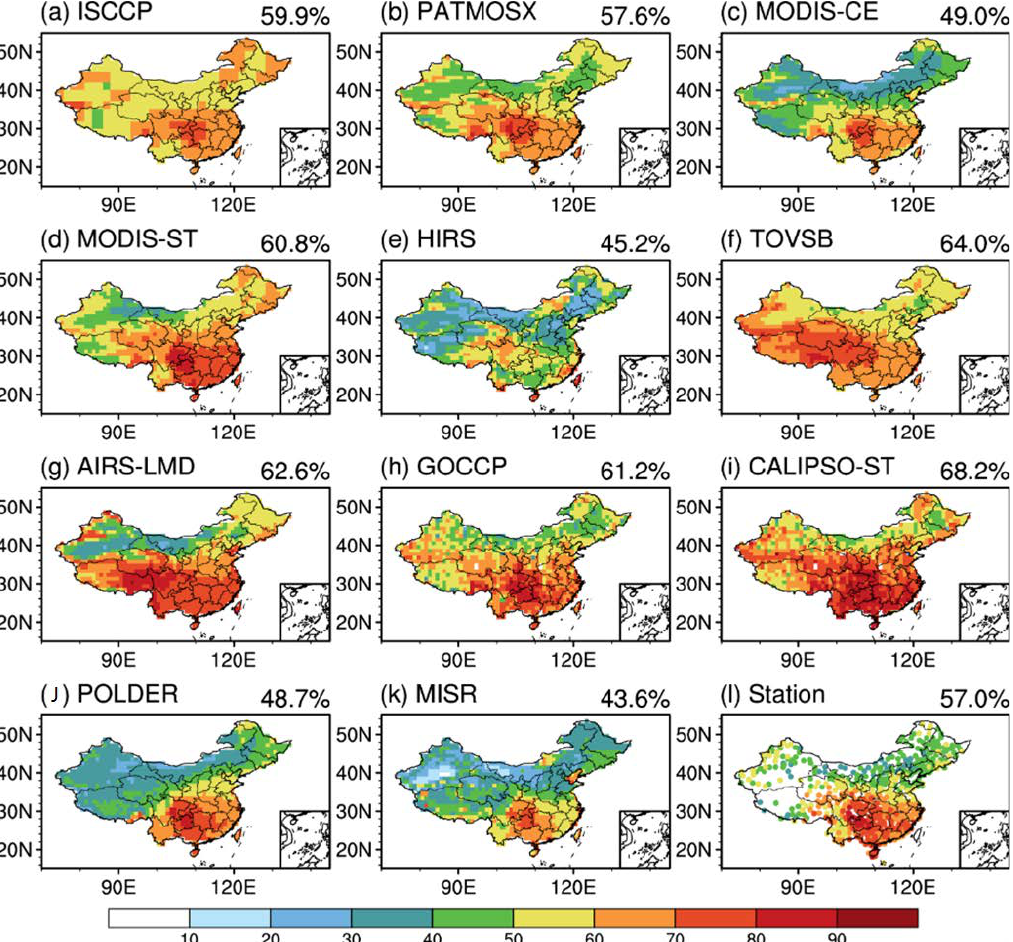
Figure 2. The spatial distribution of the annual average TCA (units: %) in China based on different satellite datasets: ( a ) ISCCP, ( b ) PATMOSX, ( c ) MODIS-CE, ( d ) MODIS-ST, ( e ) HIRS, ( f ) TOVSB, ( g ) AIRS-LMD, ( h ) CALIPSO-GOCCP, ( i ) CALIPSO-ST, ( j ) POLDER, ( k ) MISR, and ( l ) site observation data, units: %. The upper right corner of each panel shows the mean of the annual average TCA over